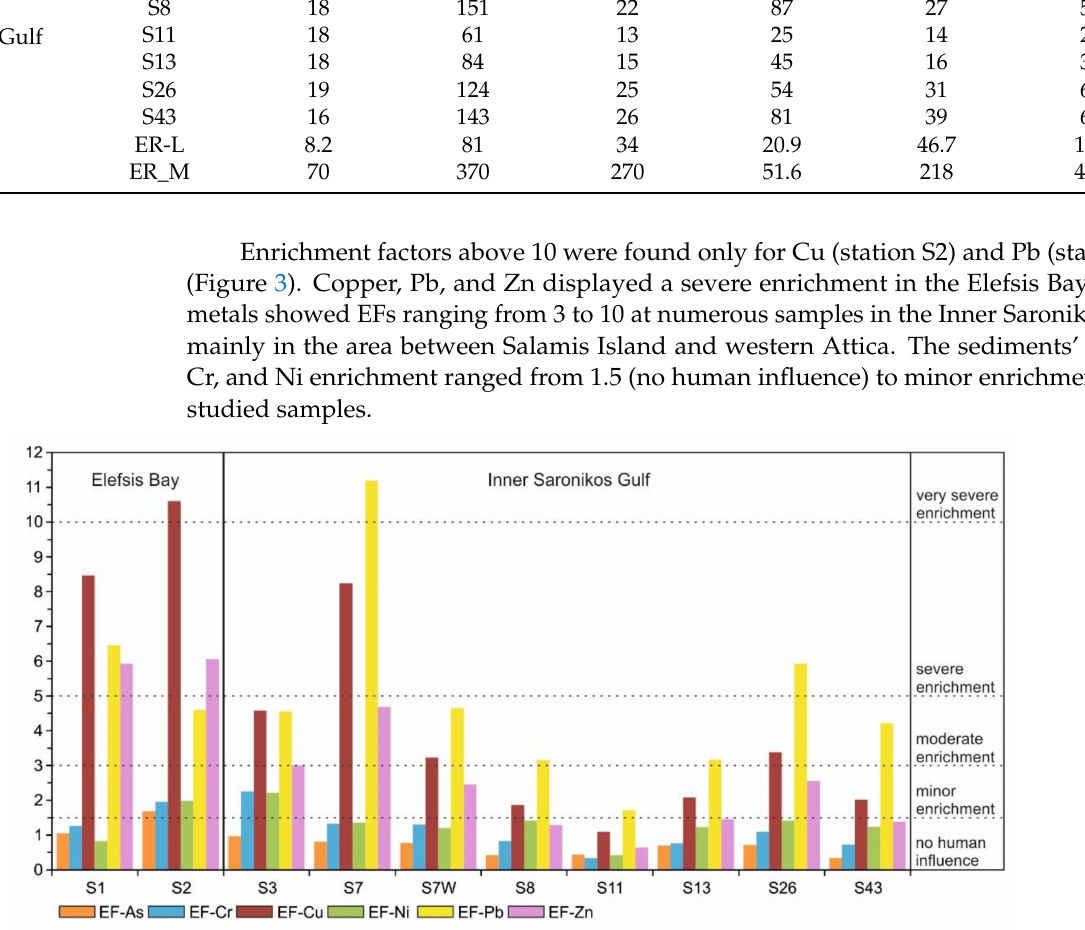
Figure 3. Sediment status according to enrichment factors calculated for the metal and metalloid content of the studied samples, recovered during the 2016 sampling